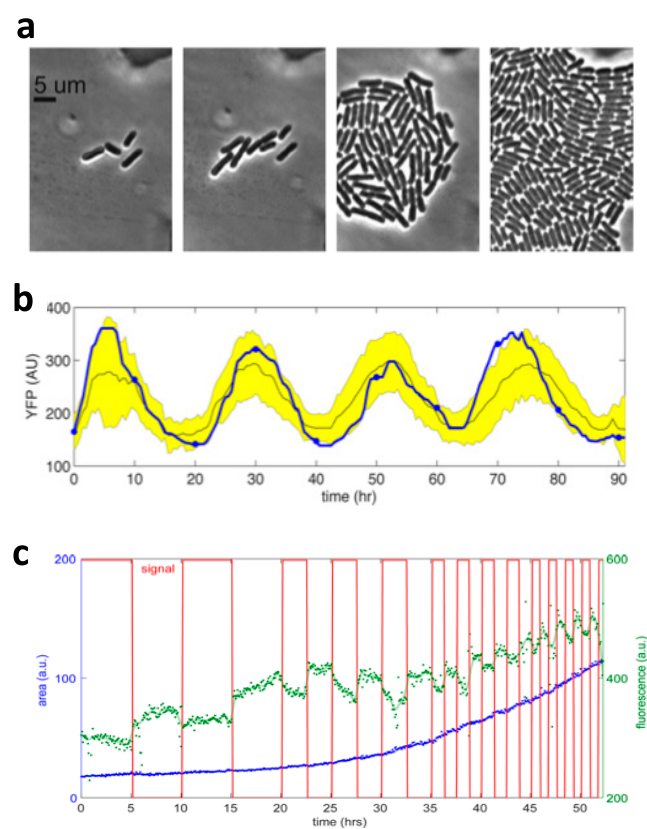
Figure 4. Microfluidic platform for long term monitoring of algae in a dynamic environment [43]. ( a ) Time-lapse image of S. elongates in a microfluidic chamber to show growth; ( b ) The fluorescence level of YFP of 134 cells from single cell tracking of circadian rhythms of gene expression of S. elongates. The blue line and yellow shaded region are the mean and the standard deviation, respectively; ( c ) Chlorophyll fluorescence of Chlorella sorokiniana ( C. sorokiniana ) under dynamic simulation with pulses of ammonia. Chlorophyll fluorescence (green line) decreased when ammonia was introduced with medium void of nitrogen. The total cell area is indicated by the blue line. Reproduced with permission from ACS Synthetic Biology; published by American Society of Chemistry, 2016.